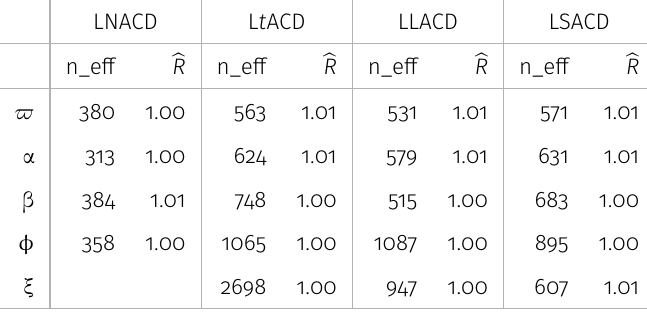
Figure 2. Trace plots and ACF for the LNACD model. Table V. Estimate of effective sample size and R